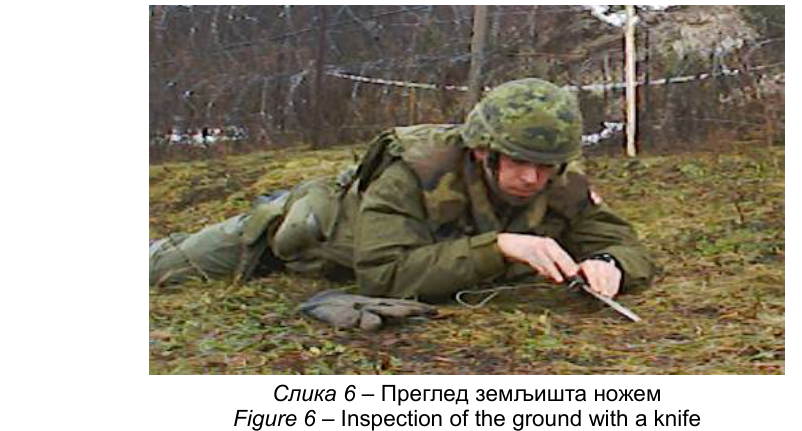
Figure 6 – Inspection of the ground with a knife Рис . 6 – Осмотр земли